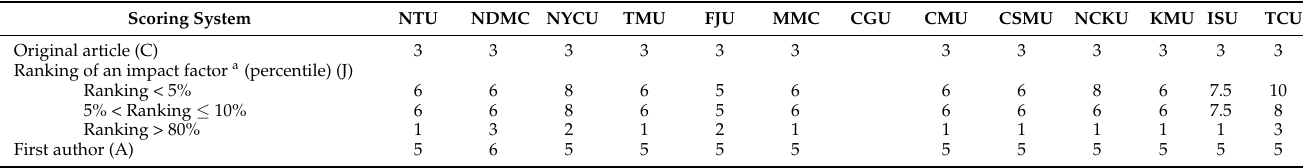
Table 3. Comparison of different weights conditional on an original article published by a clinician-educator as the first author in 13 medical schools in